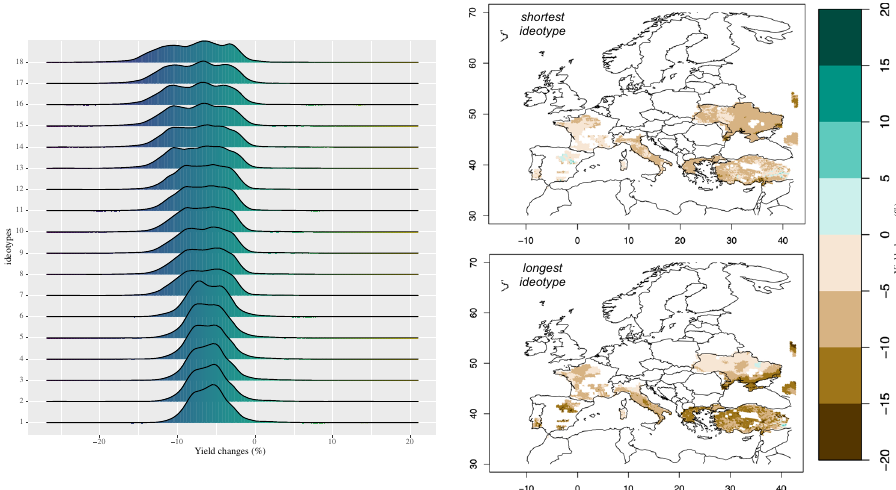
Fig. 2 Mean yield changes in 2021-2040 with no adaptation. Left Panel: Spatial probability density function of the ensemble mean yield changes in 2021 – 2040 (% w.r.t. to 1986 – 2005) for each ideotype (from the shortest 1 to the longest18) with no adaptation being implemented. Right panel: Ensemble mean yield changes in 2021 – 2040 (% w.r.t. 1986 – 2005) of the shortest and longest ideotypes. Colours in the right panel are associated with the estimated changes.